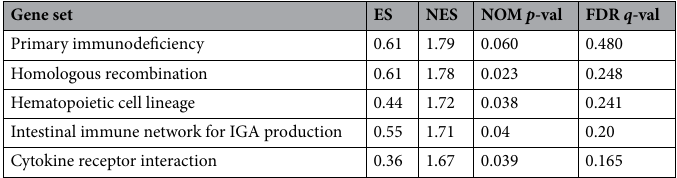
Table 1. The gene sets enriched in high-risk